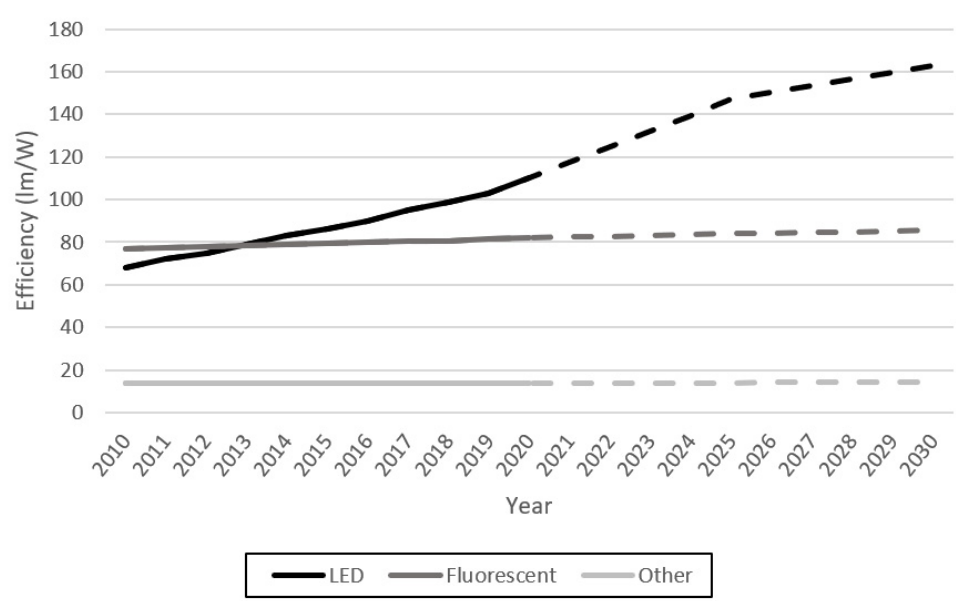
Figure 4. Expected evolution of efficiency of different lighting options. (Data collected from [66] on 27 May of 2021).